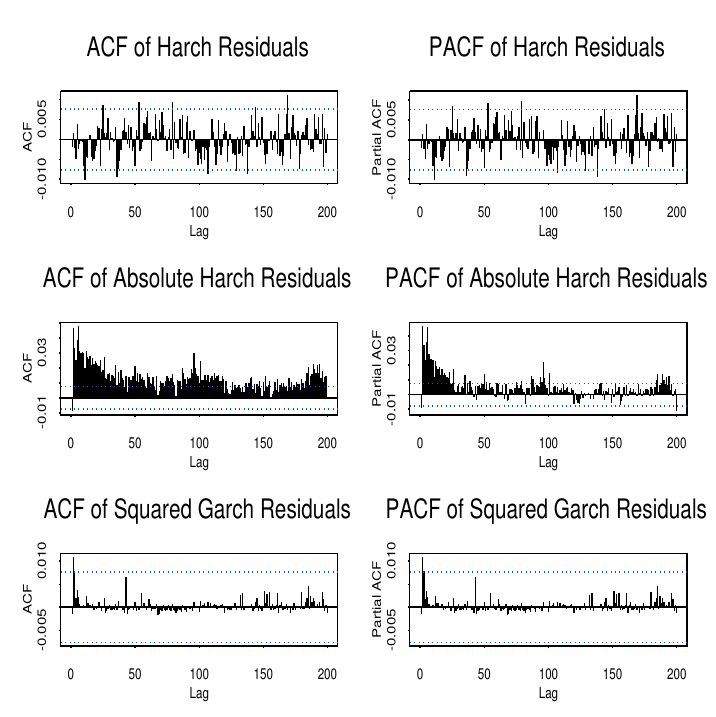
Figure 11. Autocorrelation and partial autocorrelation functions of the residuals, absolute residuals and squared residuals after PHARCH fitting.